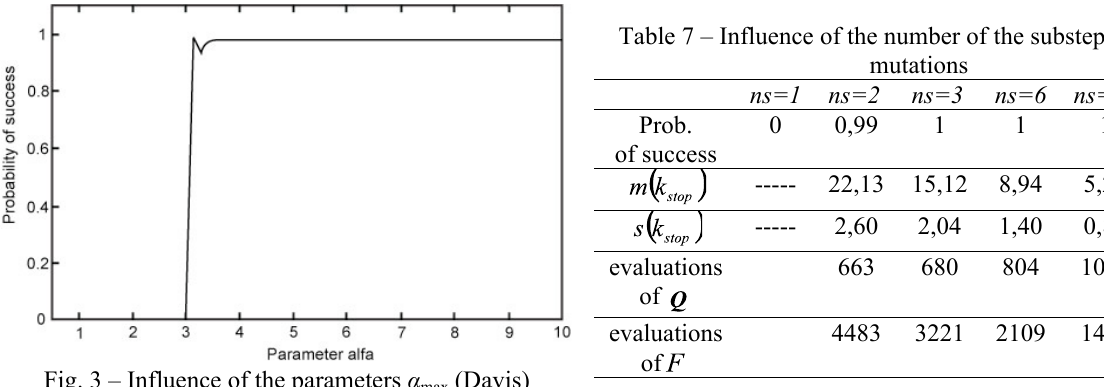
Fig. 3 – Influence of the parameters α